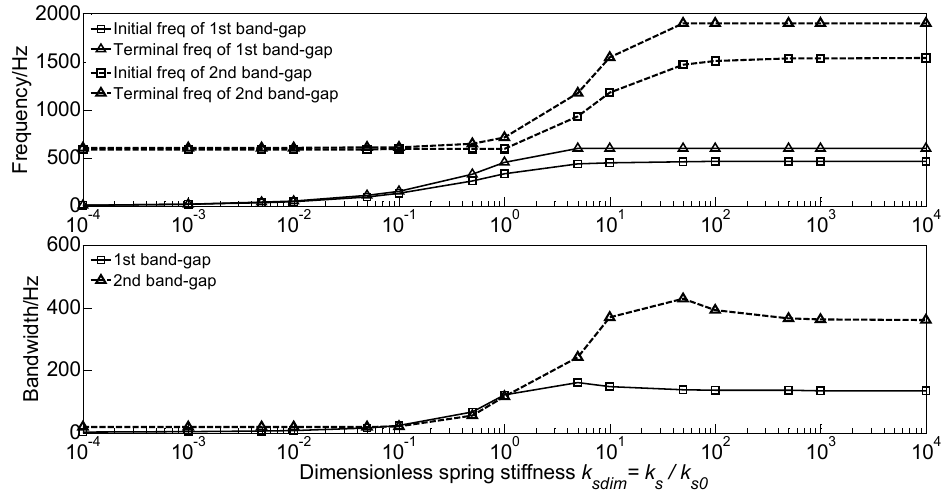
Figure 5. Band gaps maps as functions of dimensionless spring stiffness k sdim.